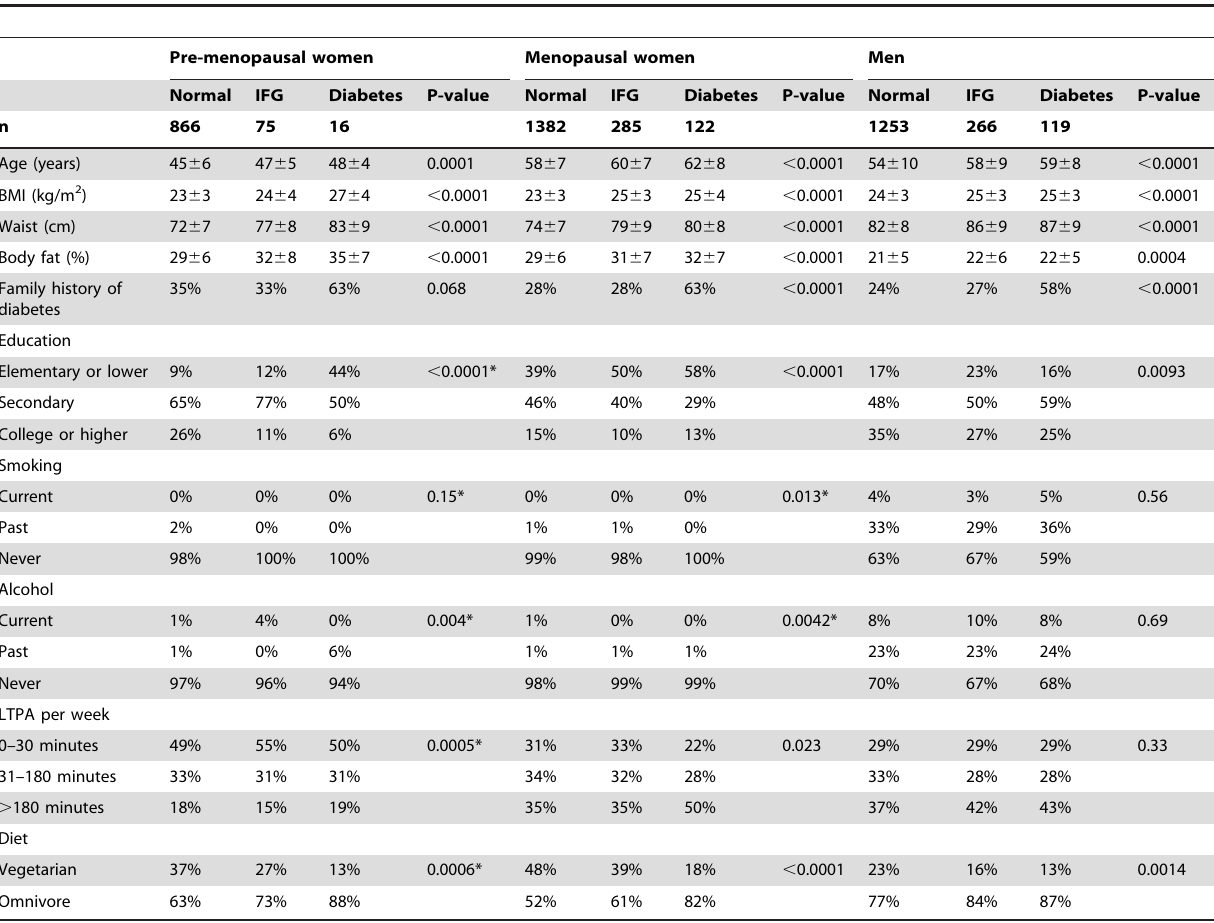
Table 1. Characteristics of participants with normal glucose, impaired fasting glucose, and